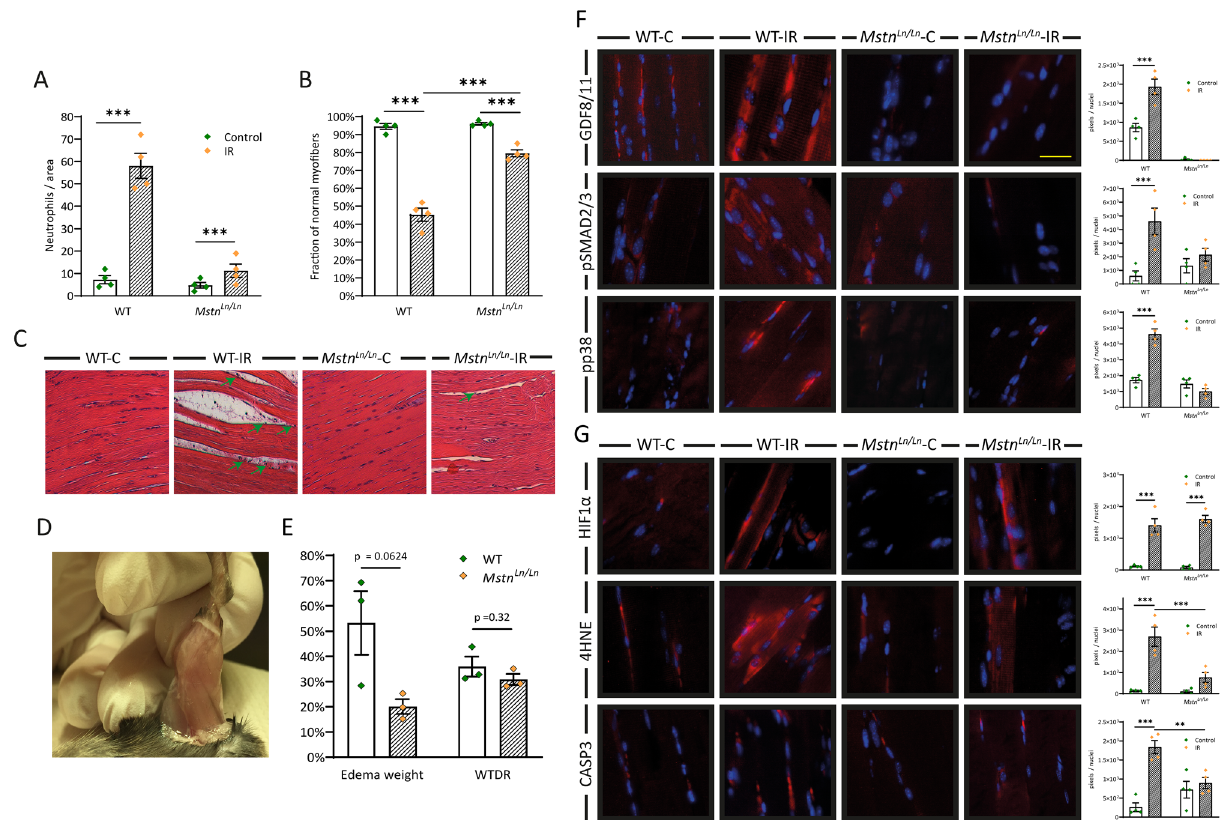
Figure 3. Mitigation of IR injury in MSTN deficient mice. ( A ) Tissue infiltration of inflammatory cells and ( B ) magnitude of myofiber deterioration assessed in HE stained skeletal muscle specimens of C57BL/6J and C57BL/6J- Mstn Ln/Ln mice. ( C ) HE stained skeletal muscle demonstrating myofiber deterioration, neutrophil immigration (green arrows), and edema formation. ( D ) Macroscopically visible edema formation due to IR injury. ( E ) Changes in the wet-to-dry ratio and edema weight compared between C57BL/6J and C57BL/6J- Mstn Ln/Ln mice (n = 3). For calculation of WTDR and edema weight see methods. ( F )